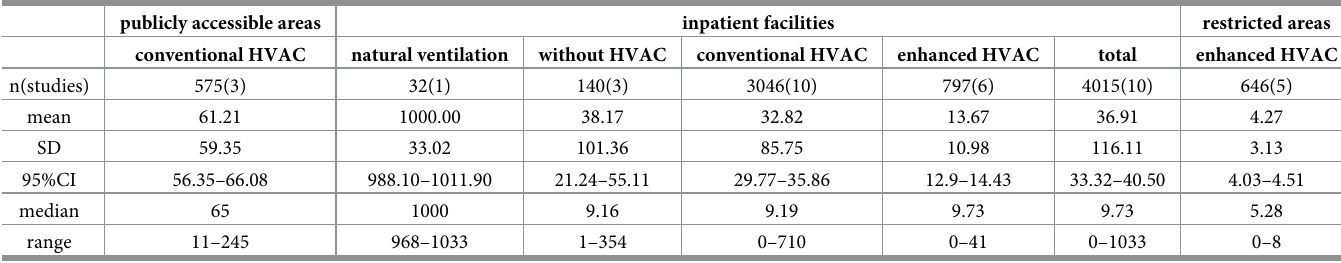
Table 4. Mean fungal counts in different areas of hospitals (CFU/m 3